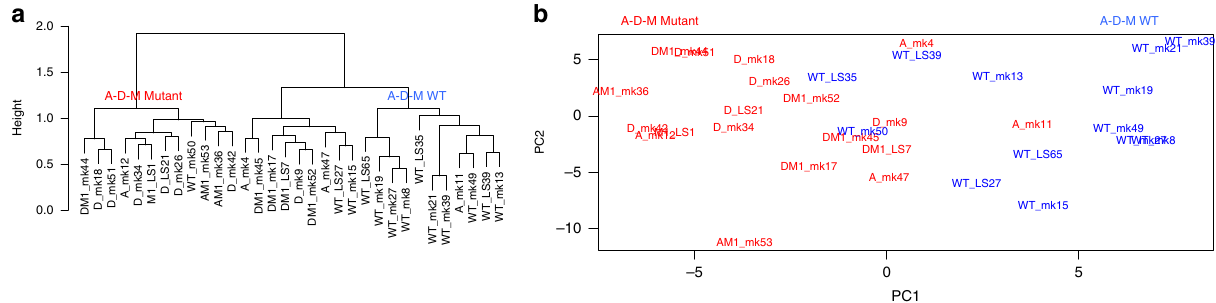
Fig. 3 Distinct DNA methylation pattern between A-D-M mutant and A-D-M WT PanNETs. a Unsupervised clustering of PanNETs using top 2000 variant CpG sites across all samples revealed two clusters. The two clusters separate A-D-M mutant from A-D-M WT PanNETs. b Principal component analysis using top 2000 variant CpG sites separated A-D-M mutant from A-D-M WT PanNETs along PC1